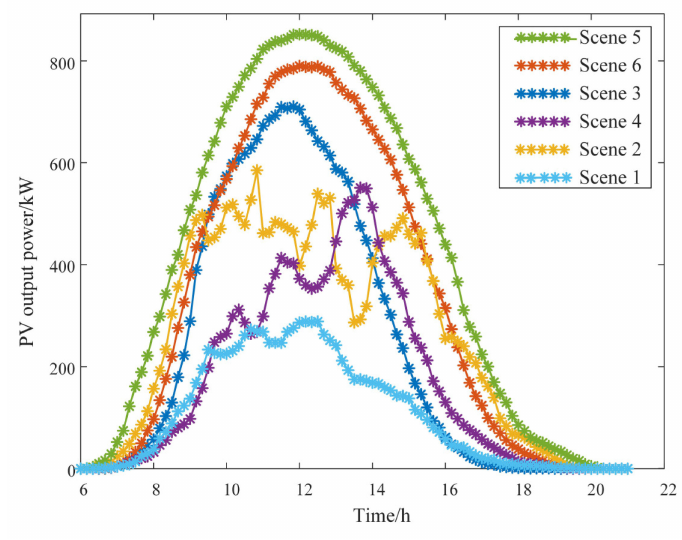
Figure 4. Clustering of typical